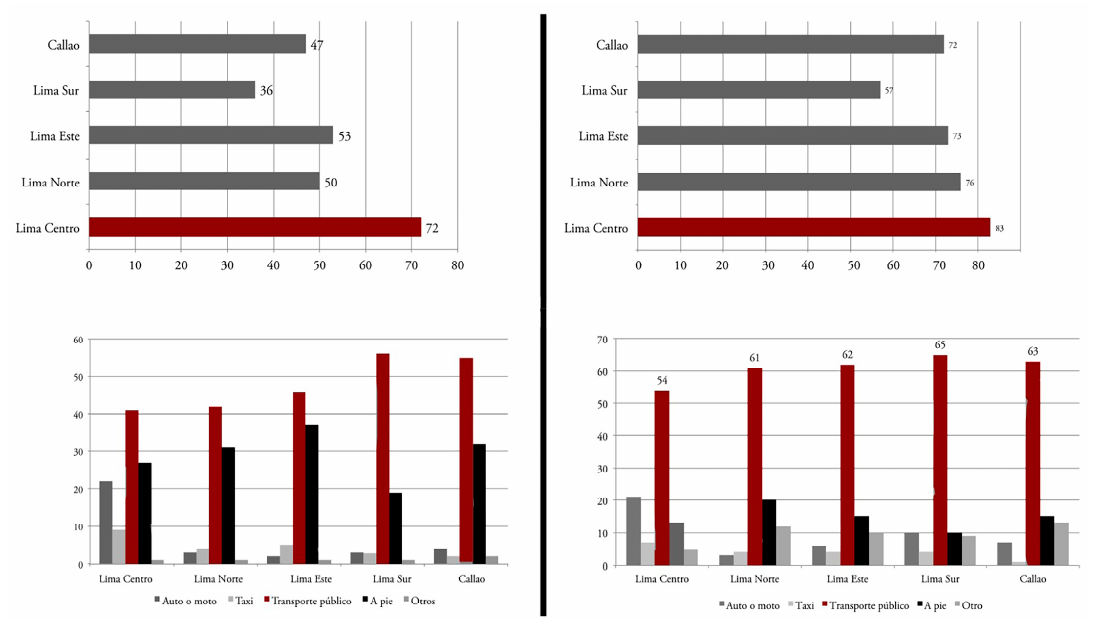
Figure 20. ( Left ): Total percentage of trips for working within same sector and chosen mode by sector of residence. ( Right ): Total percentage of trips for shopping within same sector and chosen mode, by sector of residence. Source: Reference [65] Translation by authors.